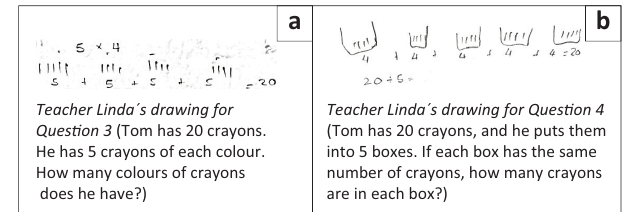
does he FIGURE 4: Teacher Linda’s drawings.